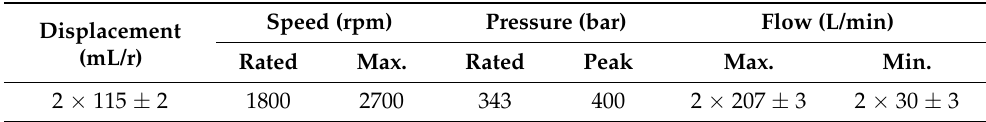
Table 1. Specifications of the 115 × 2 double-compound axial piston pump.